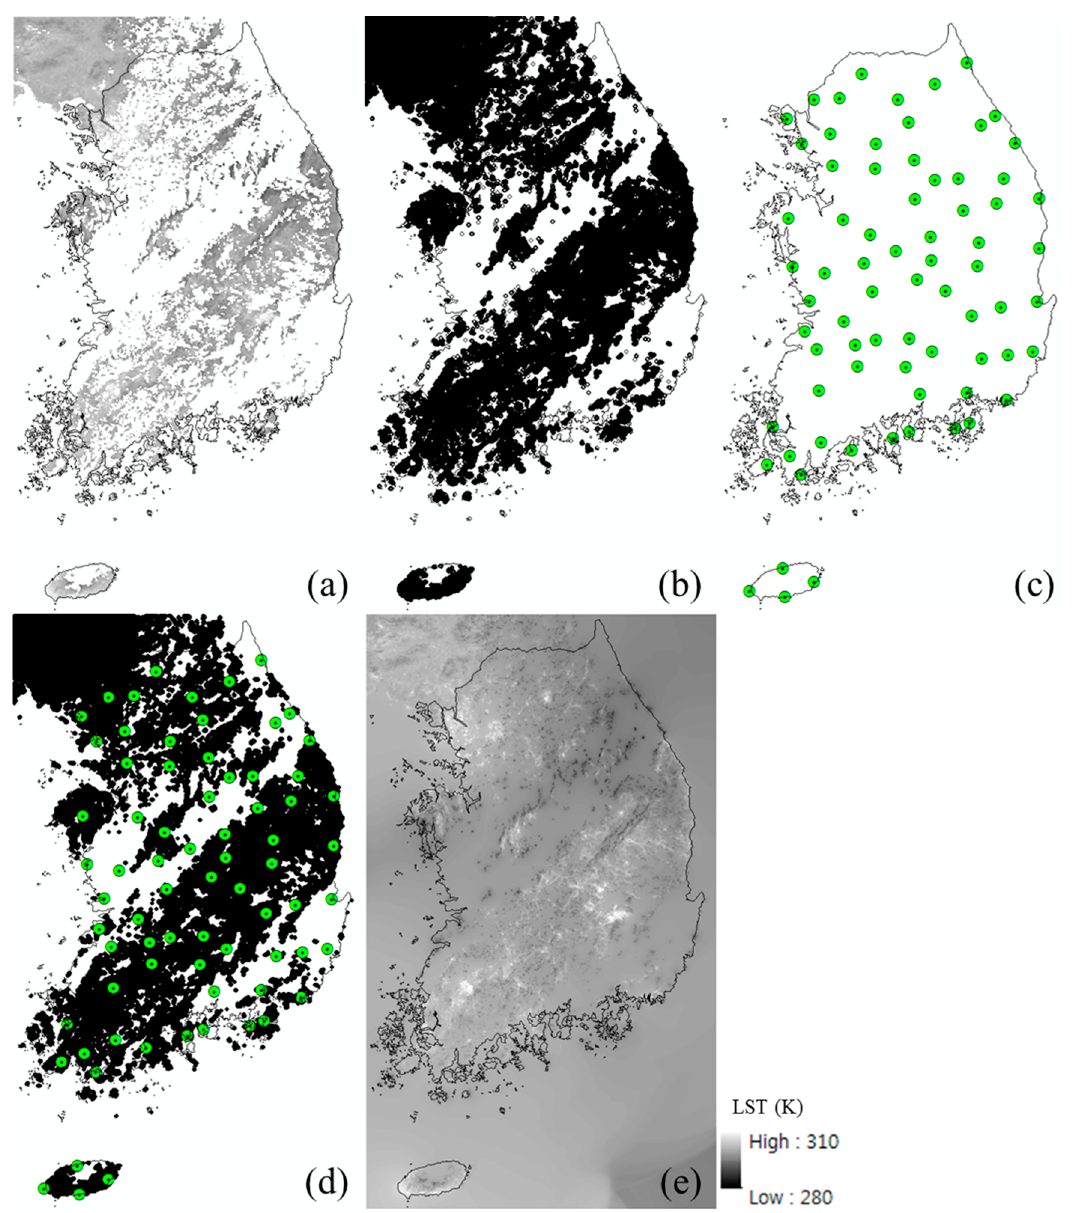
Figure 4. Filled LST data production process at 1 September 2013: ( a ) original LST data; ( b ) valid pixel data extracted from the MODIS LST data; ( c ) ground measured LST; ( d ) merged LST data between the MODIS LST and ground measured LST; and ( e ) gap-filled LST data.